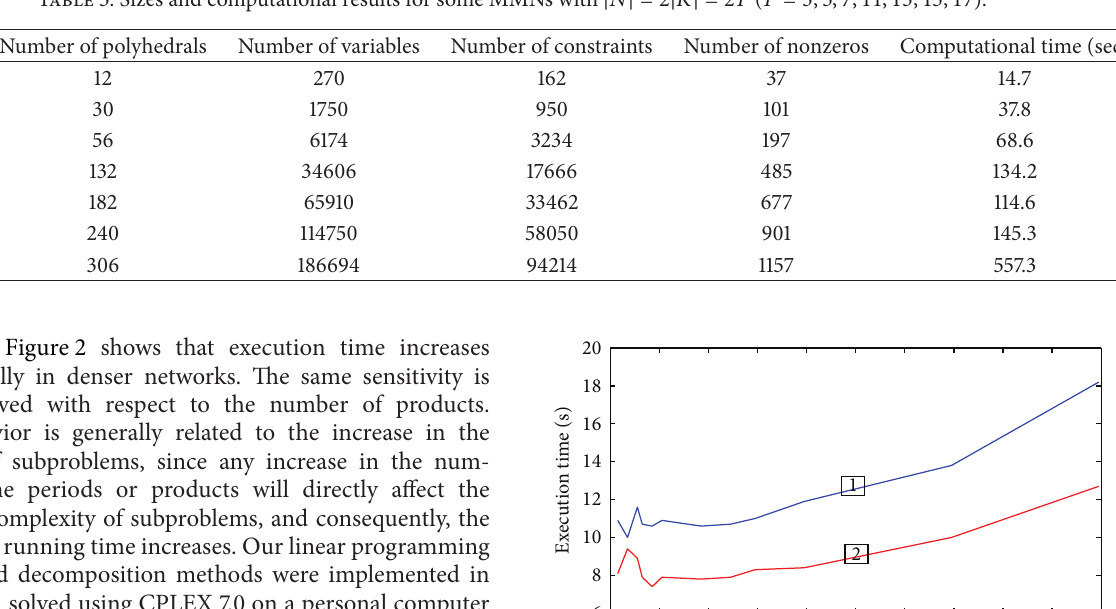
Table 3: Sizes and computational results for some MMNs with |𝑁| = 2|𝐾| = 2𝑇 ( 𝑇 = 3,5, 7, 11, 13, 15, 17 ).